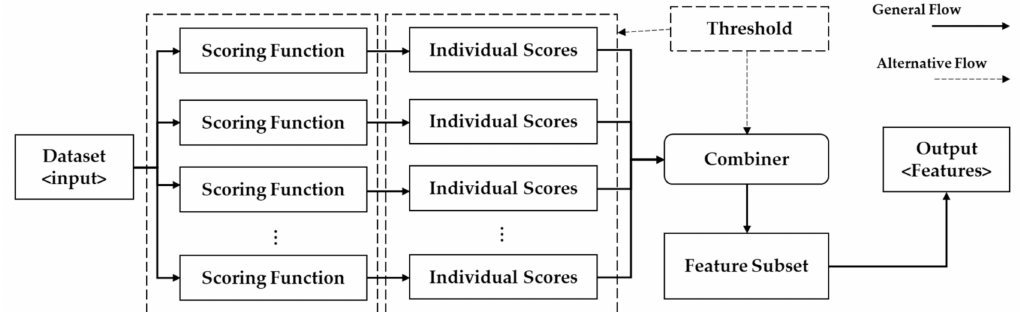
Figure 2. Schematic diagram of an ensemble feature